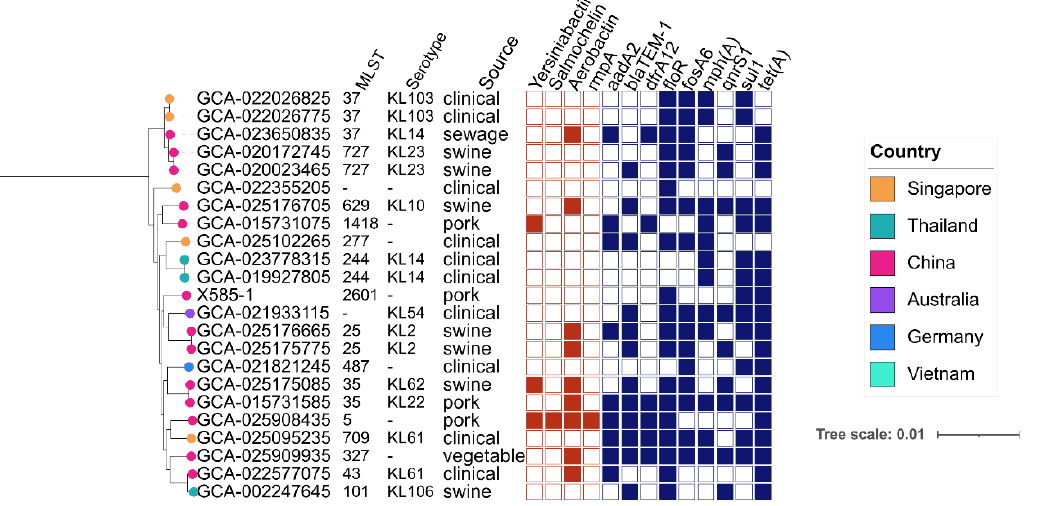
Figure 3. Phylogenetic relationship of 23 tet (X)-positive K. pneumoniae isolates. Resistance genes and virulence genes are indicated by squares; solid graphics indicate yes, and hollow graphics indicate no.